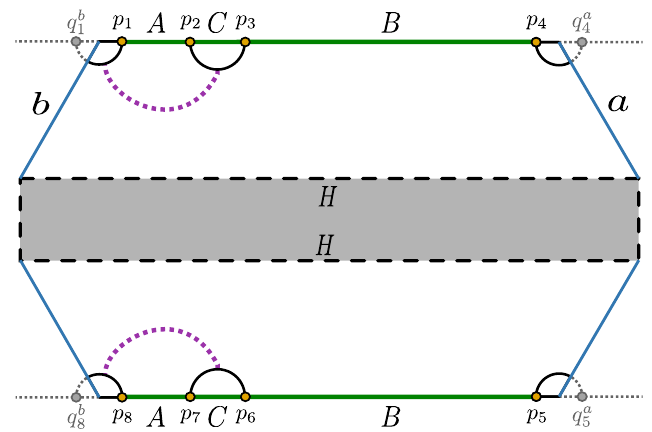
= r I − (cid:15) , q b = r I − (cid:15) 1 8